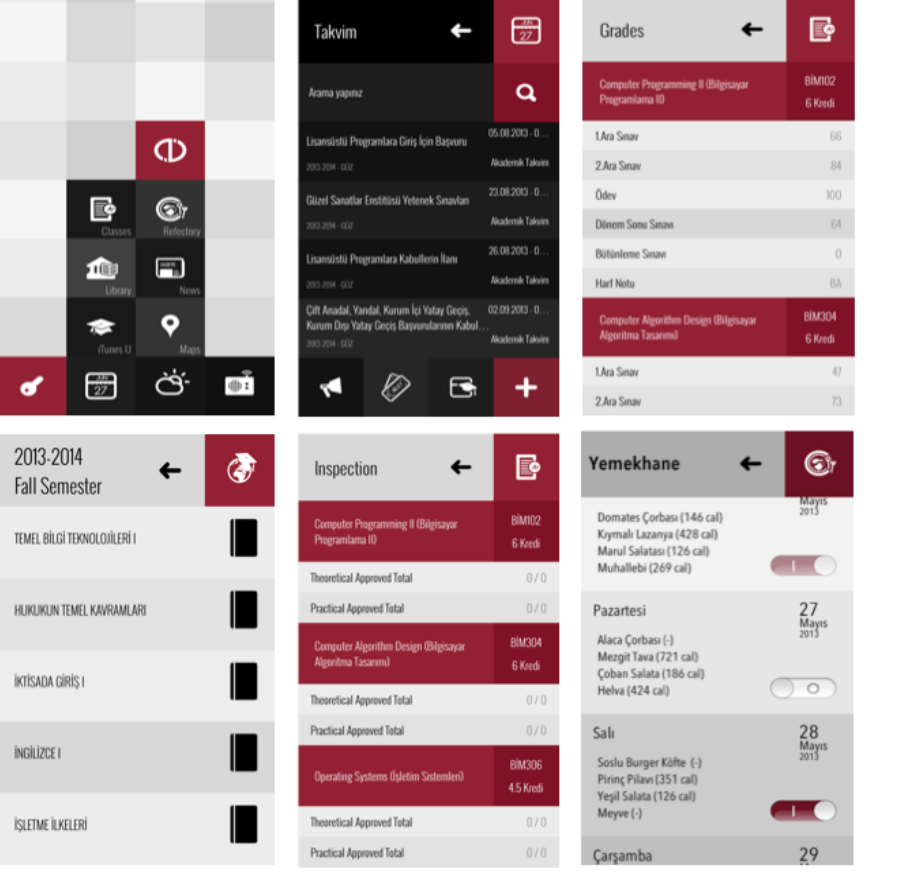
Figure 3 iOS and Android with the same look and feel, starting version